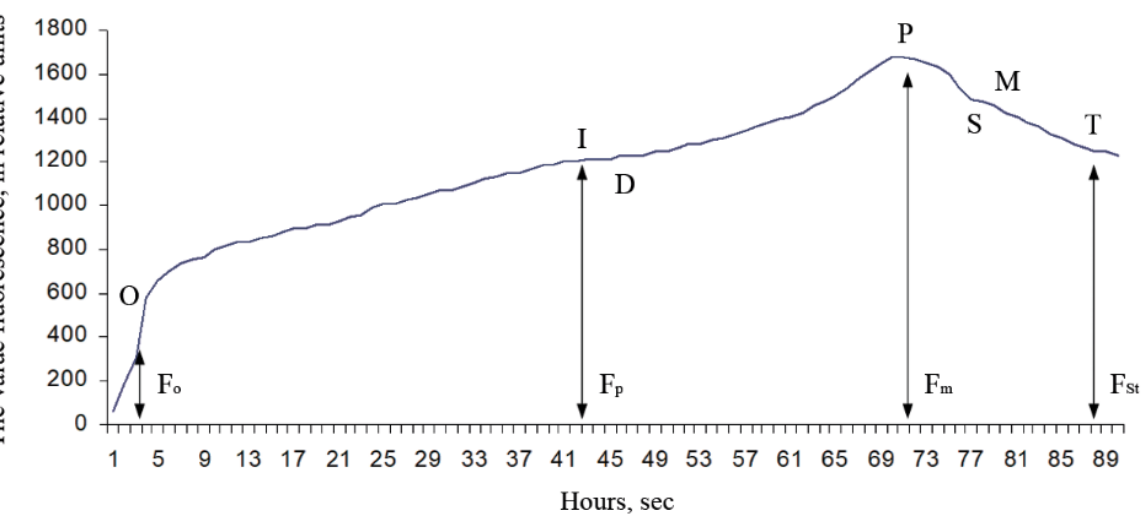
Figure 2. Typical chlorophyll fluorescence induction curve [45]: F 0 is the initial value of fluorescence induction after irradiation is turned on; F p is the “plateau” fluorescence induction value; F m is the maximum value of fluorescence induction; F St is the stationary value of fluorescence induction after light adaptation of a plant leaf .